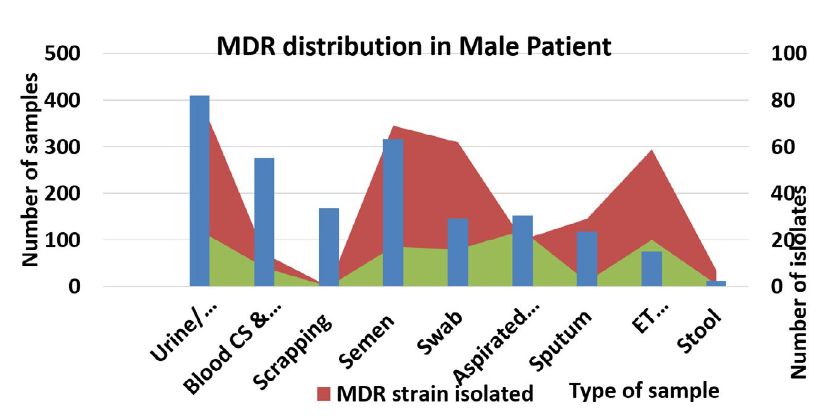
Fig. 2. MDR distribution among male patients